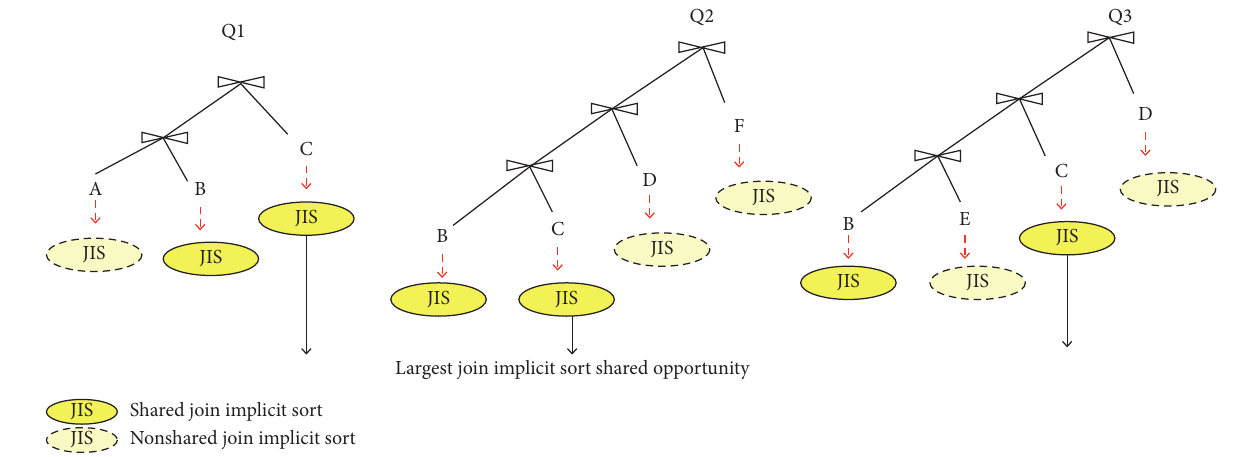
Figure 12: The J-MOTH system Exploiter Example. Table 3: Example of J-Moth System using SP Technique.